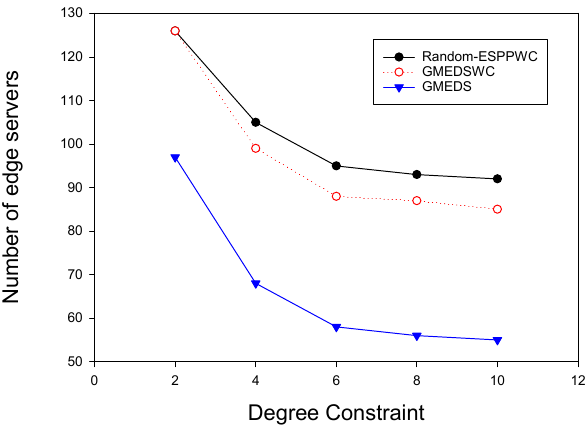
Figure 12. The impact of cluster degree constraint on the number of edge servers.